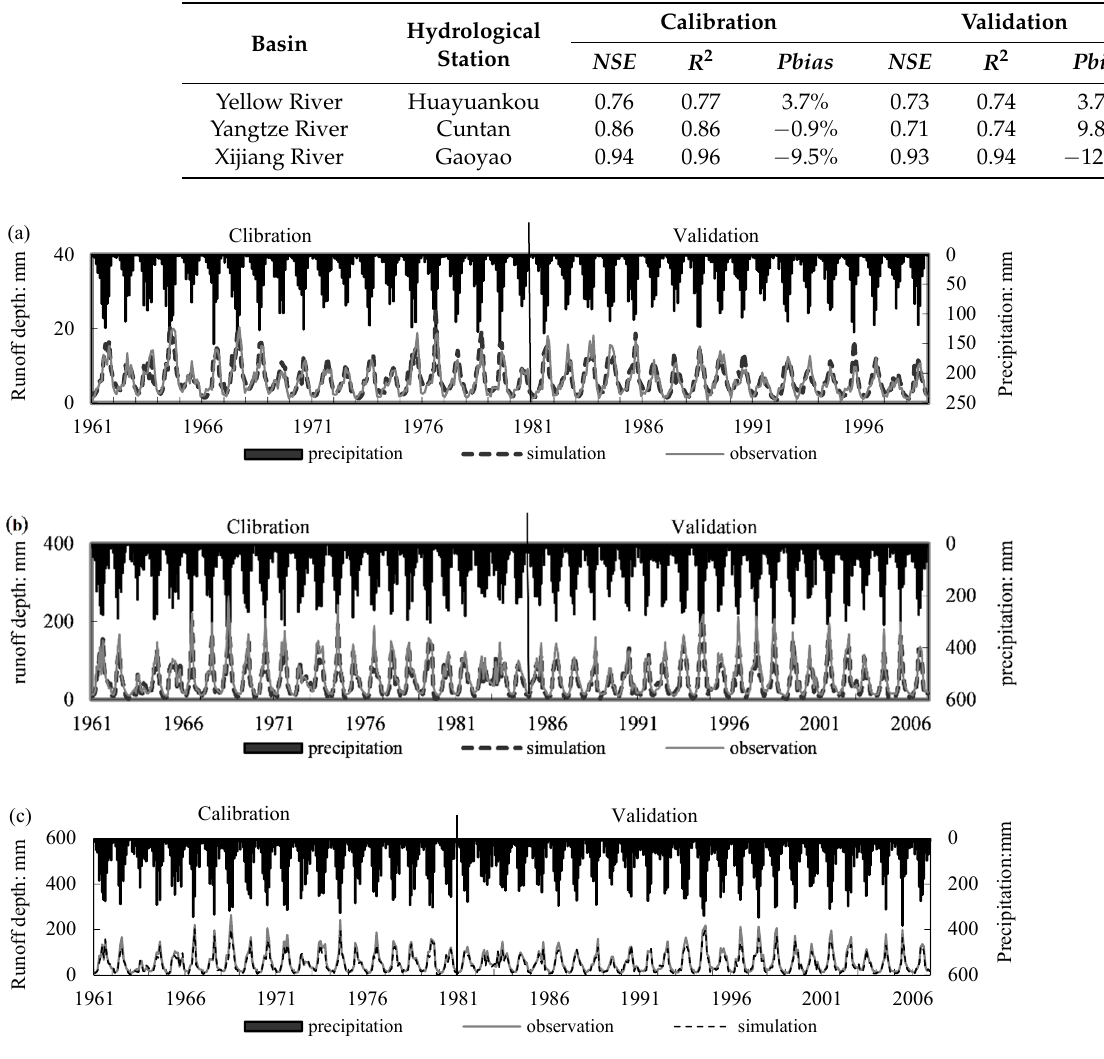
Figure 2. Observed and simulated monthly runoff during periods of calibration and validation at ( a ) Huayuankou station along the Yellow River, ( b ) Cuntan station along the Yangtze River, and ( c ) Gaoyao station along the Xijiang